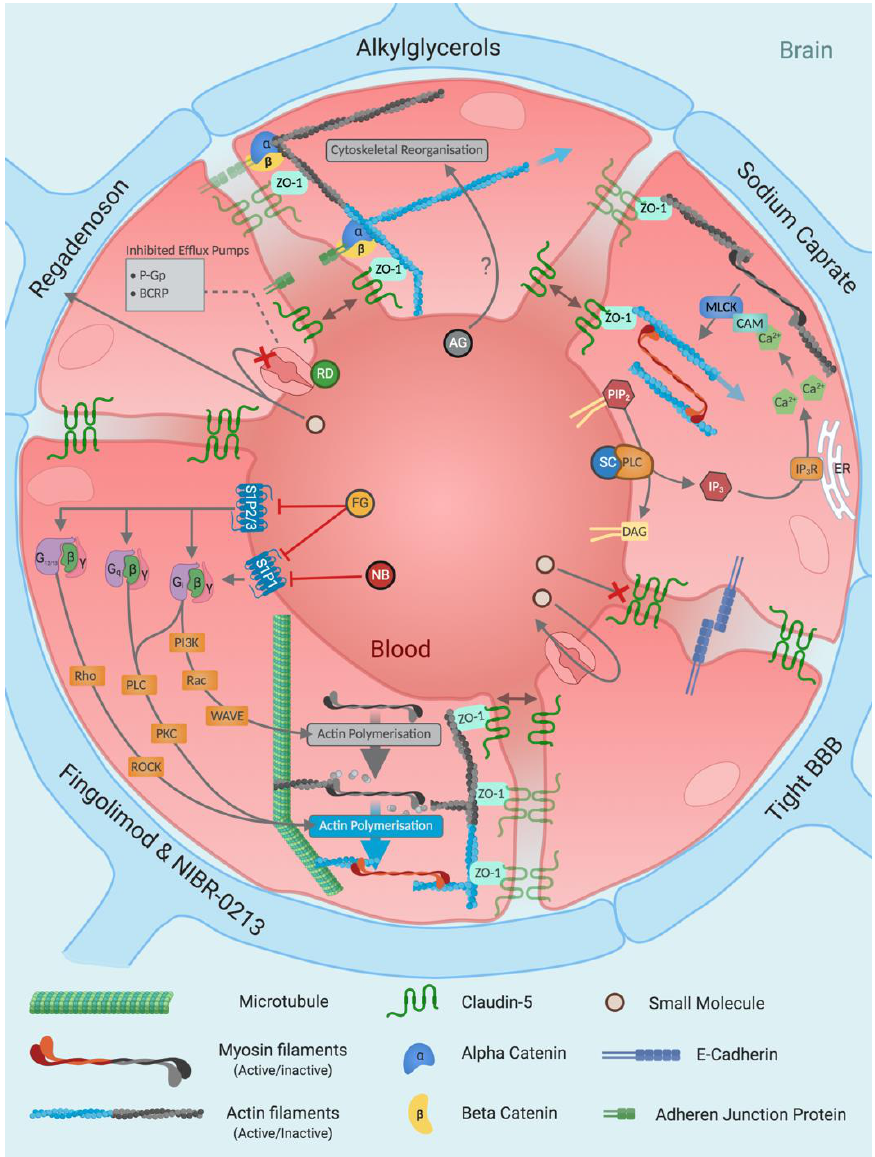
Figure 4. Mechanism summary for blood–brain barrier-modulating small molecules. Small mole- cules are a diverse category of blood–brain barrier modulators that primarily induce paracellular flux by altering tight junctions via indirect interactions through rearrangement of the cytoskeleton.